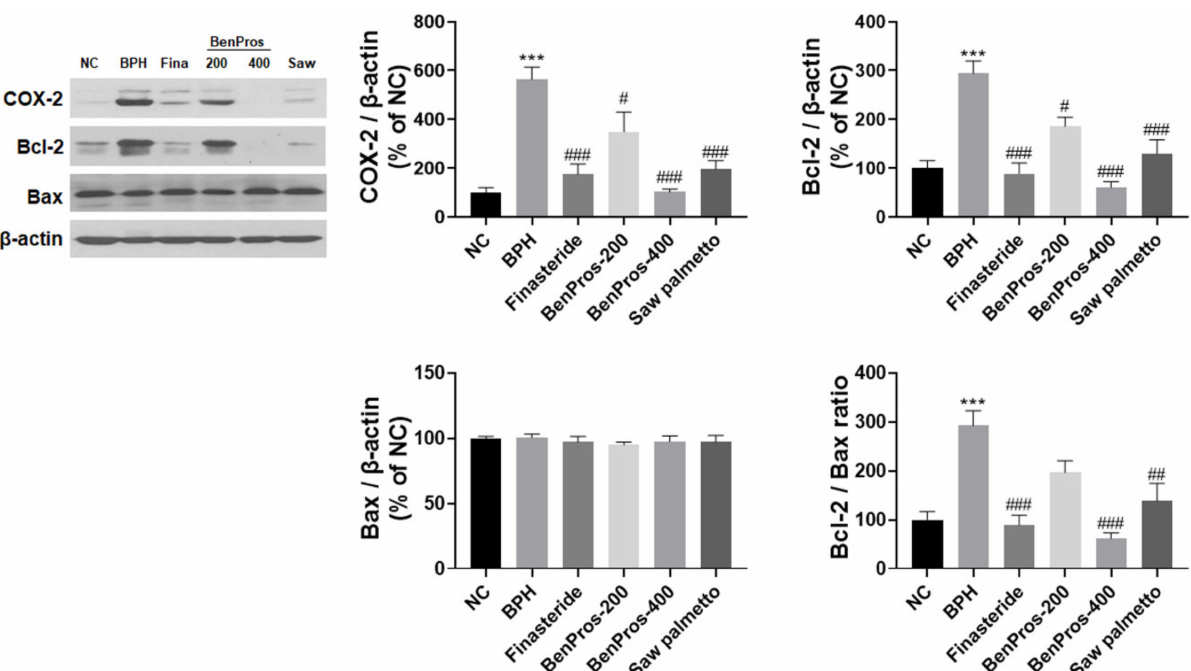
Figure 4. Effects of BenPros on expression of cyclooxygenase-2 (COX-2) and apoptosis proteins in BPH rats. Representative western blots of COX-2, B-cell lymphoma 2 (Bcl-2) and BCL2 Associated X (Bax). Blots are normalized to β -actin and values are presented as the mean ± standard error of the mean of 6 rats per group. *** p < 0.001 vs. NC; # p < 0.05, ## p < 0.01 and ### p < 0.001 vs. BPH. Fina; finasteride, Saw; saw